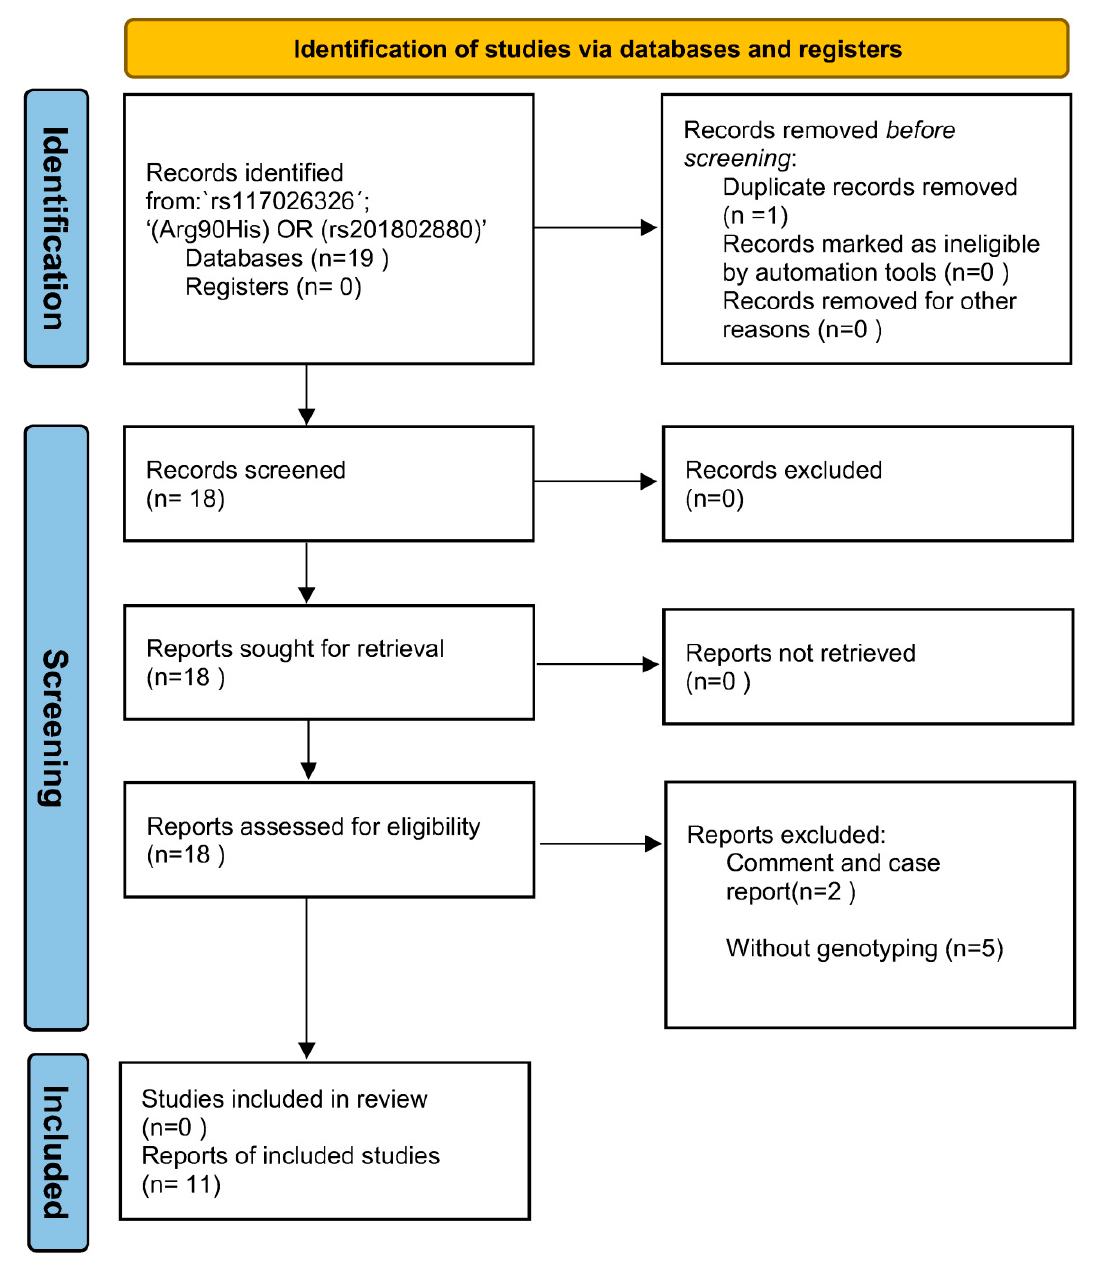
Figure 2. The PRISMA flow diagram of the meta-analysis.